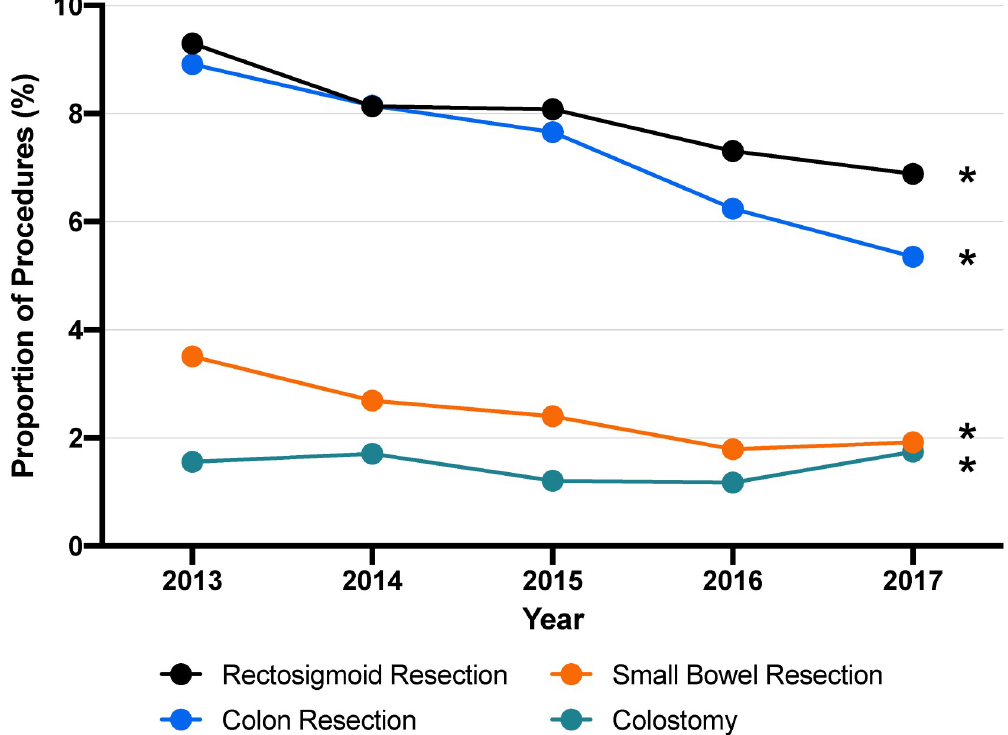
Fig 2. The proportion of all cytoreduction procedures involving the gastrointestinal tract each year. � Significance at P <